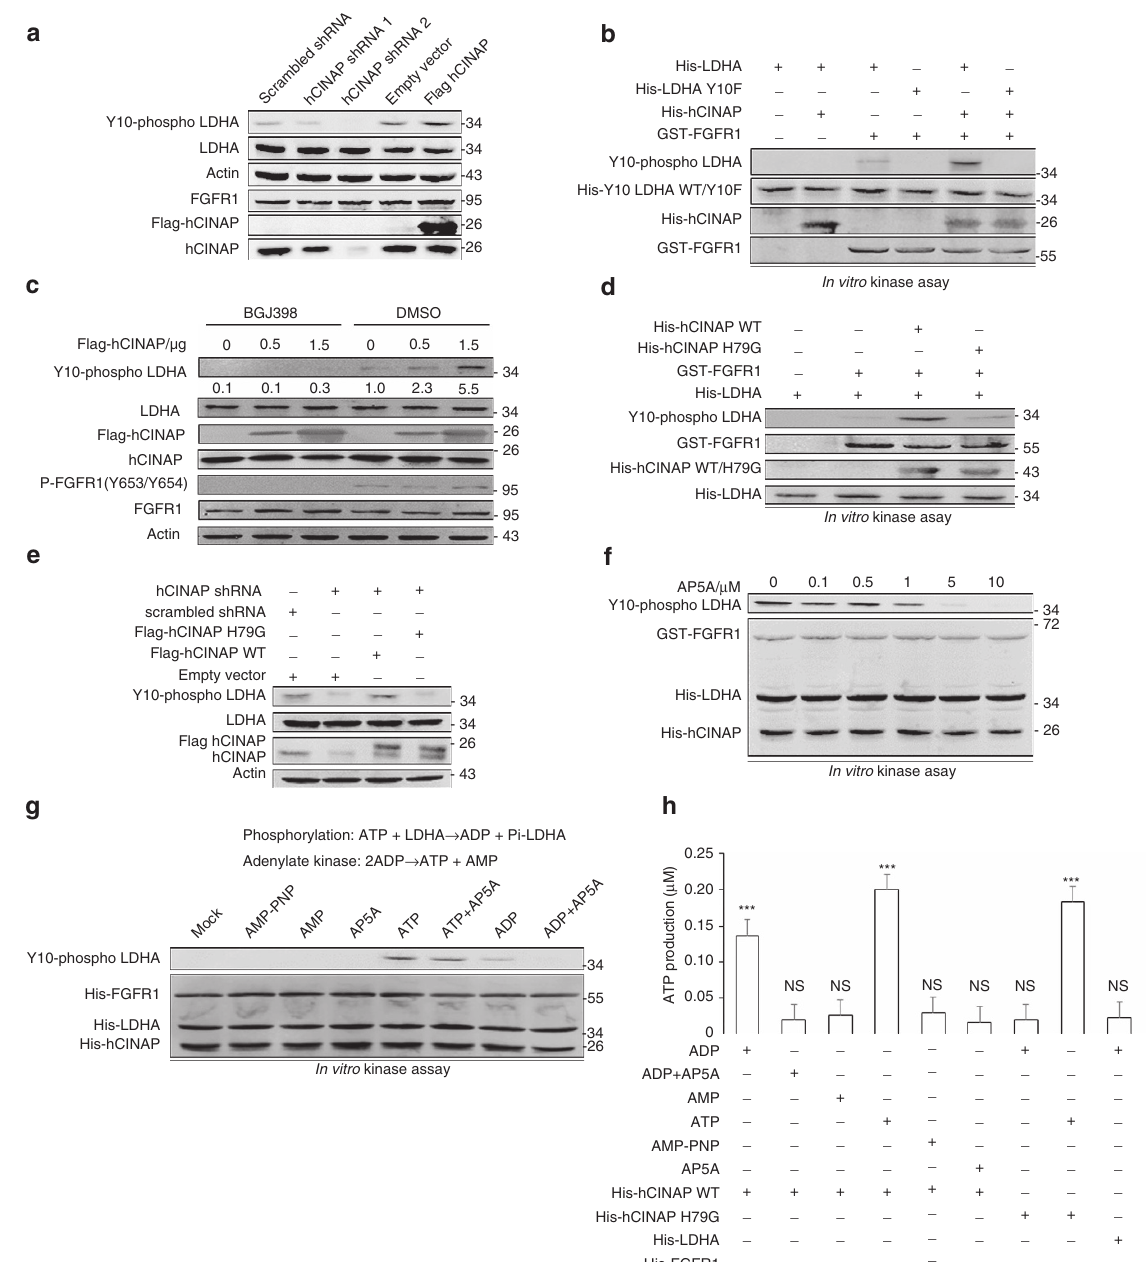
Figure 4 | Adenylate kinase hCINAP promotes LDHAY10 phosphorylation catalysed by FGFR1. ( a ) Western blot analysis of LDHAY10 phosphorylation levels in SW480 cells transfected as indicated. See also hCINAP-enhanced LDHA tetramerization in Supplementary Fig. 4. ( b ) Immunoblot analysis of LDHAY10 phosphorylation catalysed by FGFR1 in vitro with or without hCINAP. Y10F LDHA served as a negative control. ( c ) Western blot analysis of LDHA Y10 phosphorylation in SW480 cells transfected with the indicated plasmids and treated with FGFR1 inhibitor BGJ398 (10nM) or DMSO. ( d , e ) The effects of wild-type hCINAP and H79G mutant hCINAP on FGFR1-catalysed LDHA Y10 phosphorylation in vitro ( d ) and in SW480 cells expressing the indicated plasmids ( e ). ( f ) The effect of AP5A on LDHAY10 phosphorylation in FGFR1 kinase assay in vitro . ( g ) In vitro FGFR1 kinase assay with various combinations of protein and nucleotides as indicated. ( h ) ATP levels were measured by a luciferase reporter system in assays with the indicated combinations of protein and nucleotides. The results are expressed as mean ± s.e.m. of three independent experiments. Asterisks indicate significant differences (*** P o 0.001 versus second column) determined by Student’s t